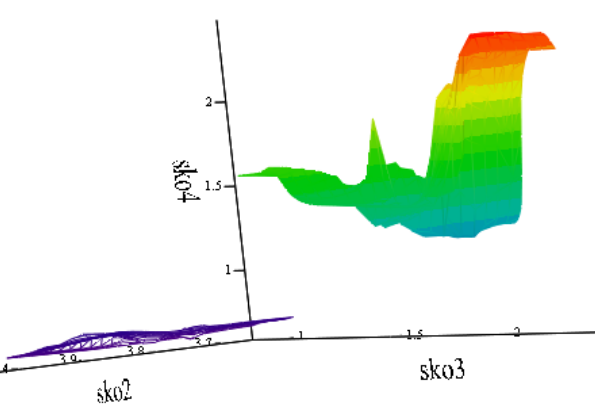
Figure 9. The standard deviation of the selected components of the legitimate tra ffi c (color plane) and